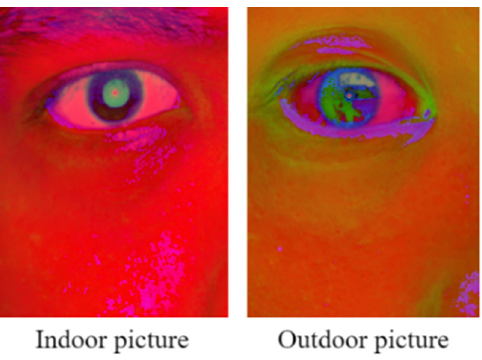
Figure 46. HSV eye images captured for Asian people in indoor and outdoor environments.